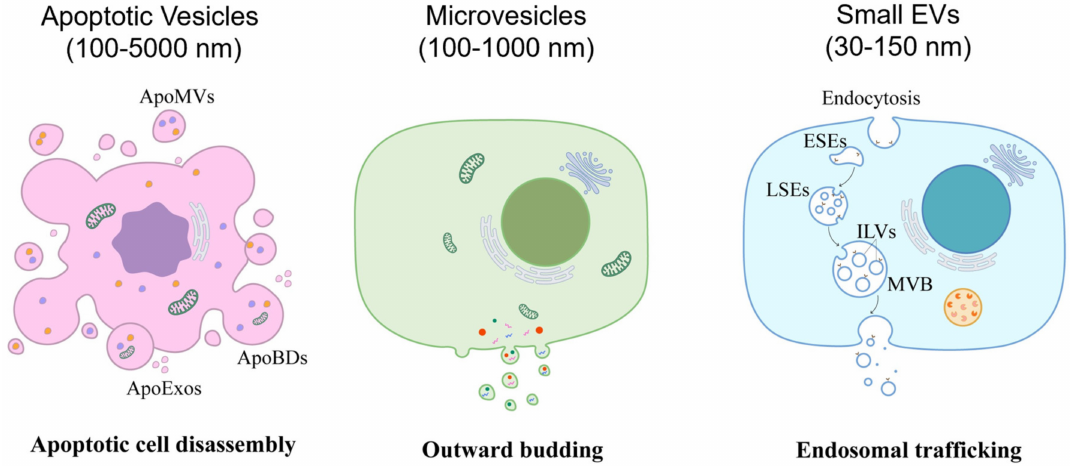
Figure 1. Graphic representation of the different types of extracellular vesicles (EVs). Generally, EVs are divided into apoptotic vesicles (ApoVs), microvesicles (MVs), and small EVs (sEVs) according to their biogenesis. ApoVs are released from disassembled apoptotic cells and are categorized as apoptotic bodies (ApoBDs), apoptotic microvesicles (ApoMVs), and apoptotic exosomes (ApoExos), based on their different sizes. MVs are generated via the direct outward budding of the plasma mem- brane. The biogenesis of sEVs comprises the formation of endocytic vesicles, early sorting endosomes (ESEs), late sorting endosomes (LSEs), and intraluminal vesicles (ILVs) within multivesicular bodies (MVBs), followed by release upon fusion of MVBs with the plasma